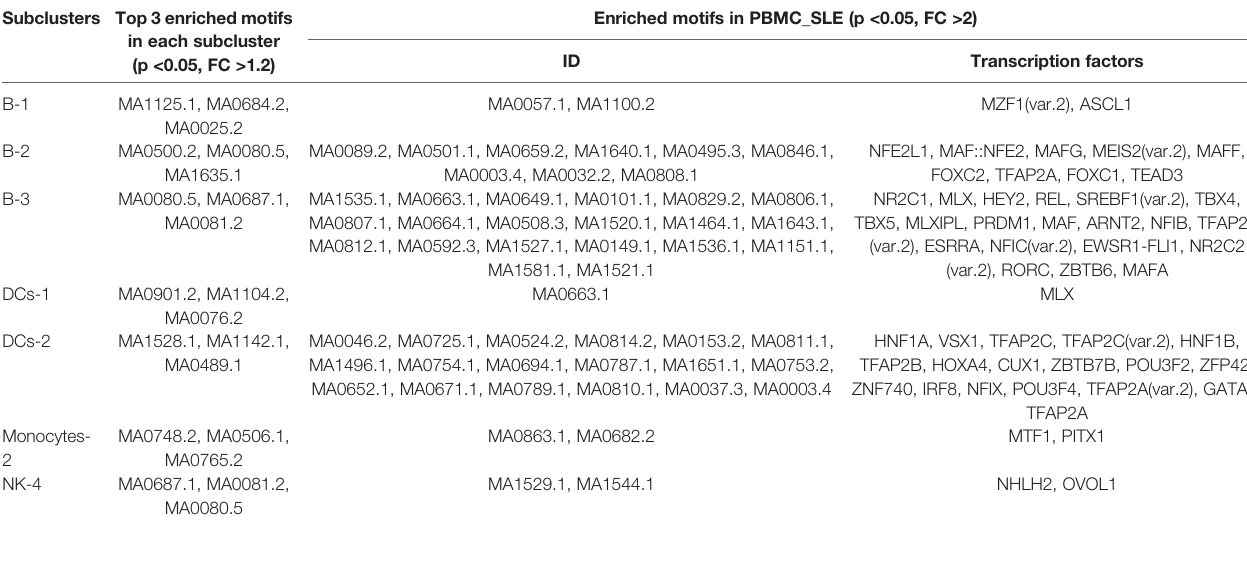
TABLE 3 | Subclusters with enriched motifs in PBMC_SLE for scATAC-seq experiments. Subclusters Top 3 enriched motifs in each subcluster (p <0.05, FC >1.2)